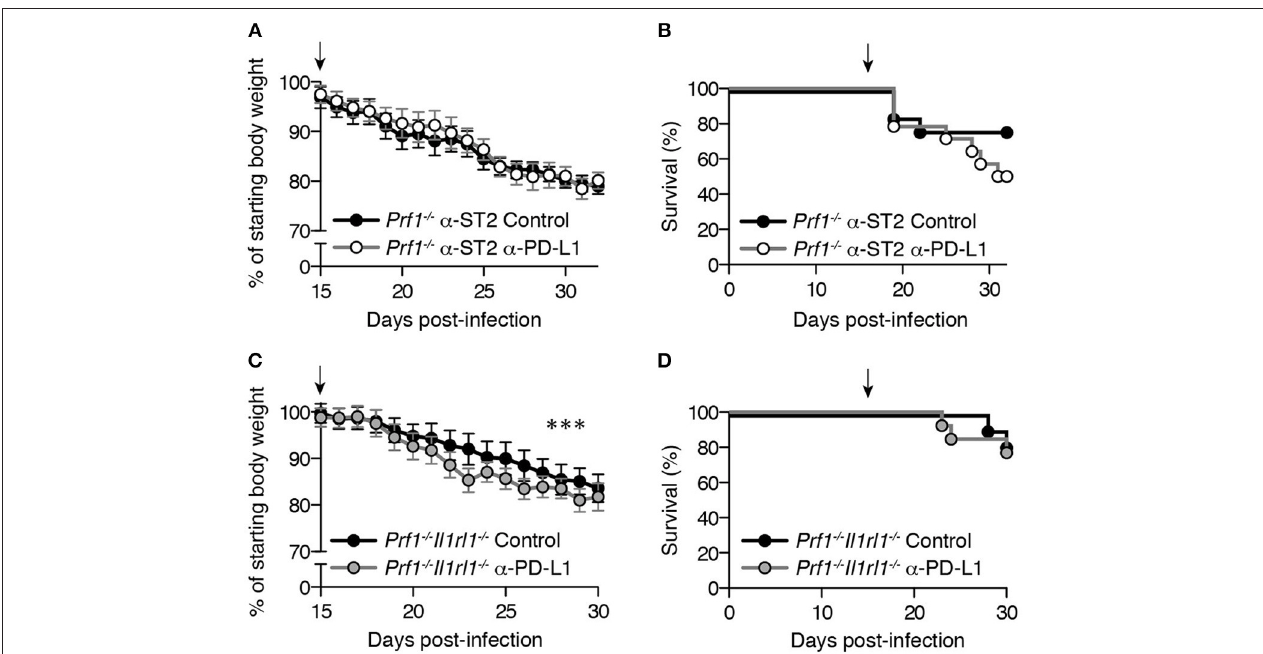
FIGURE 4 | CD8 + T cell exhaustion in LCMV-infected Prf1 − / − mice provides little clinical benefit. Mice were infected with LCMV and given 200 µ g of either α -PD-L1 or isotype control antibodies every 3 days, beginning on day 15 p.i. (indicated by an arrow). Day 15 was selected as the timepoint at which initial features of exhaustion are clearly evident(21) and PD-1 is highly upregulated on LCMV-specific Prf1 − / − CD8 + T cells ( Figure 1A ). Starting body weight was determined on day 0, and average weight did not differ significantly between the two groups from days 0 to 15 p.i. (not shown). Weight data are plotted as mean ± SEM and were analyzed by linear mixed-effects model. Survival data were analyzed by log-rank (Mantel-Cox) test. (A) Body weight and (B) survival of Prf1 − / − mice acutely treated with α -ST2 antibody every other day from days 3–15 p.i. prior to administration of α -PD-L1 or isotype control antibodies. N = 13–14 mice/group, pooled from 2 independent experiments. (C) Body weight and (D) survival of Prf1 − / − Il1rl1 − / − mice receiving either α -PD-L1 or isotype control antibodies. N = 11–13 mice/group, pooled from 2 independent